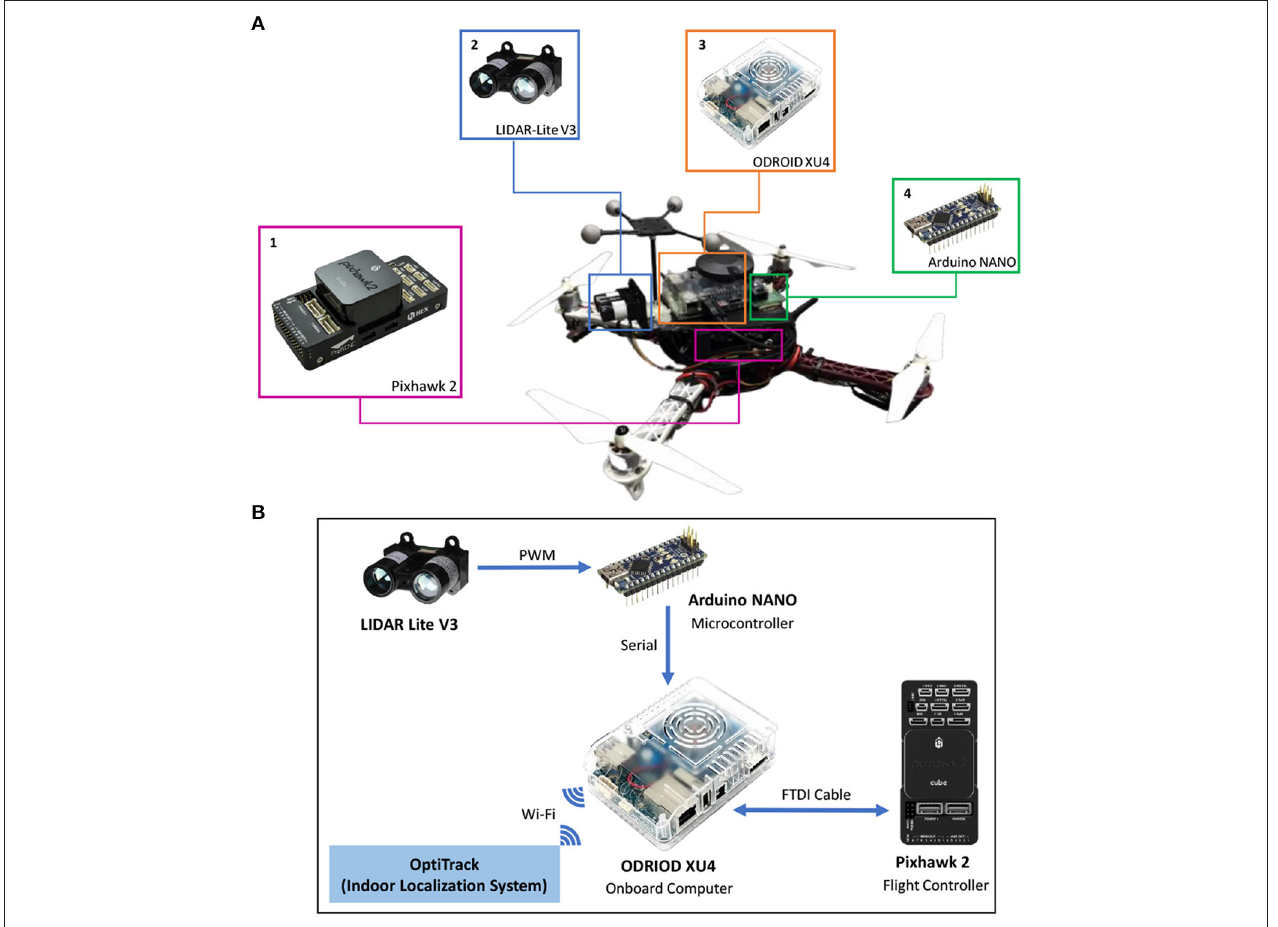
FIGURE 4 | (A) The UAV with (1) Pixhawk 2.1 flight controller and its accessories, (2) distance sensor, (3) Odroid onboard computer, and (4) Arduino NANO microcontroller. (B) Schematic connection of the